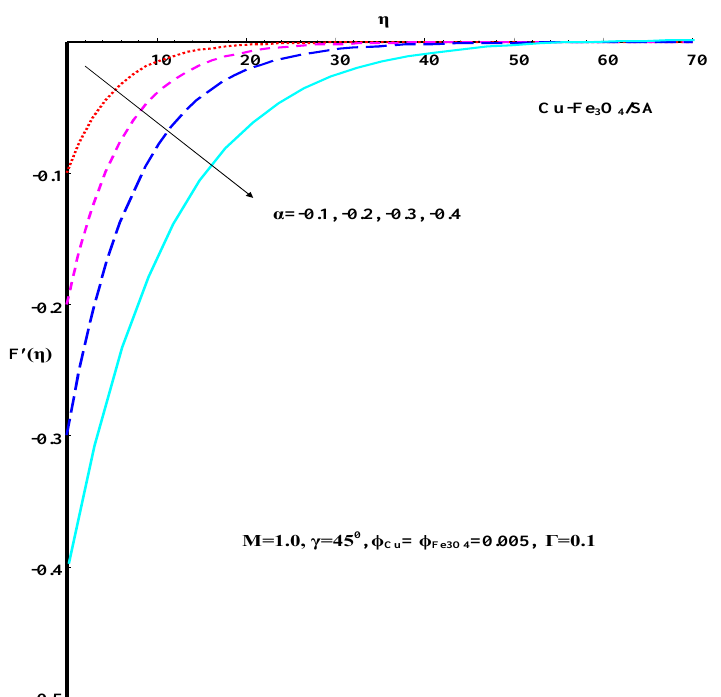
Figure 1. Effect of shrinking ( α < 0 ) case on velocity profile.